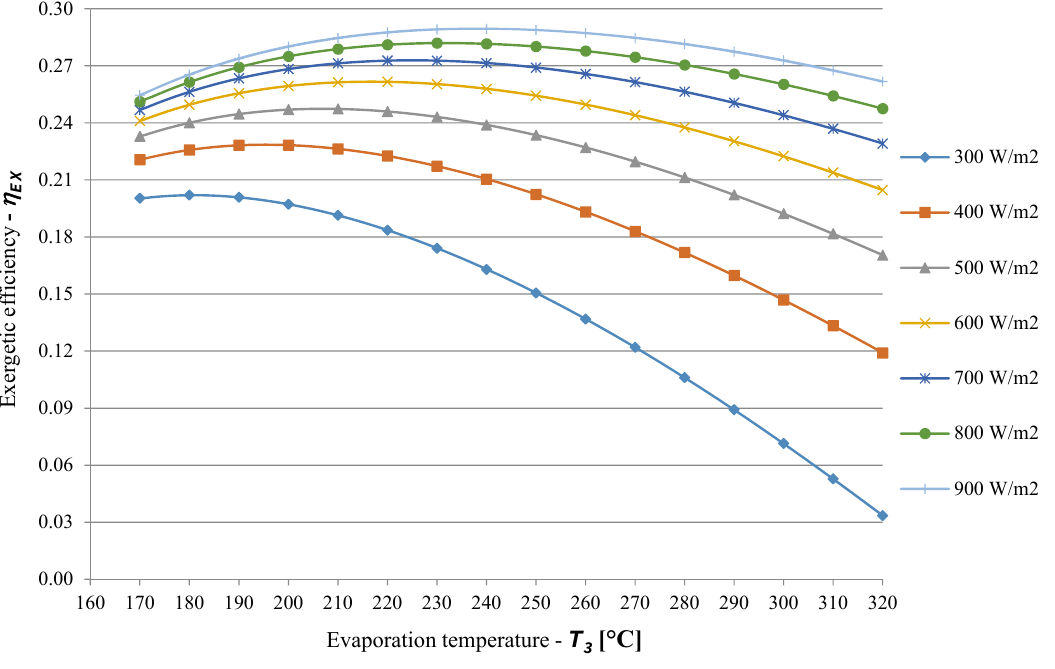
Figure 8. Exergetic efficiency versus vaporization temperature under growing solar radiation when the condensation pressure is fixed at 0.7 bar.